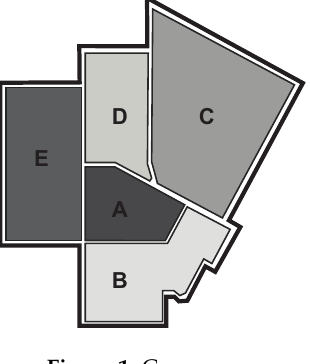
Figure 1. Campus